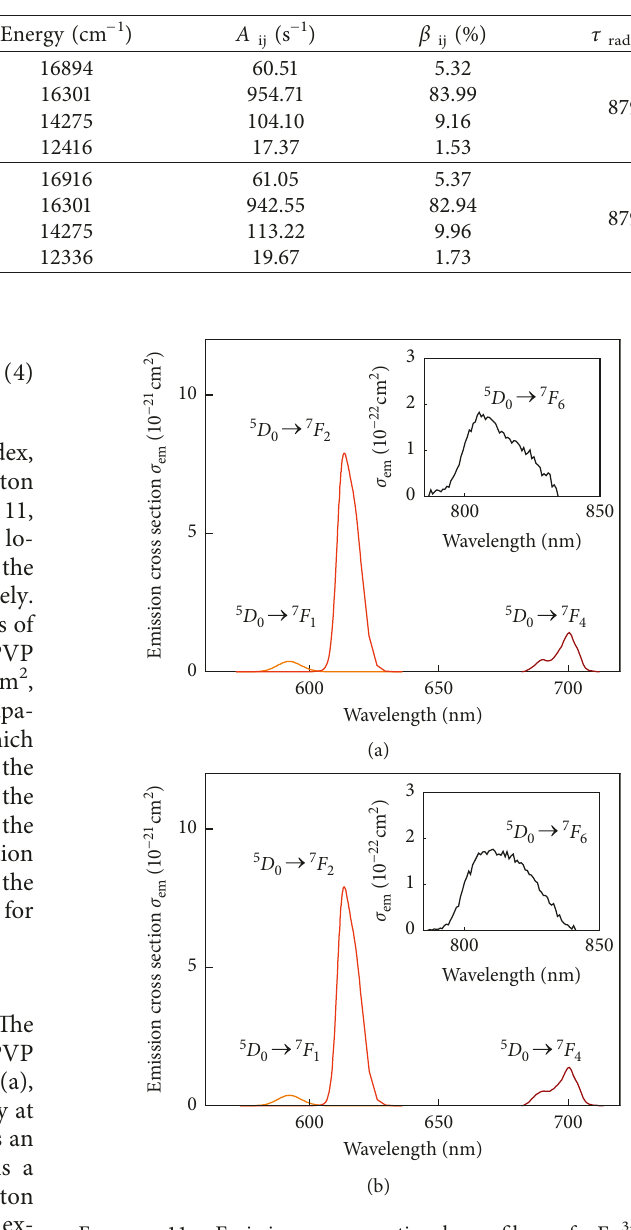
ij , branching ratios β ij , and calculated radiative lifetimes τ rad of